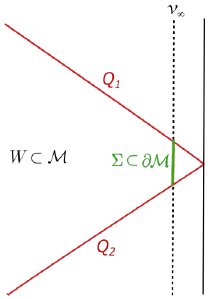
Figure 2 . The wedge holography setup. Here Σ −→ 0 is implemented through introducing a large cutoff surface v near the boundary and then taking v ∞